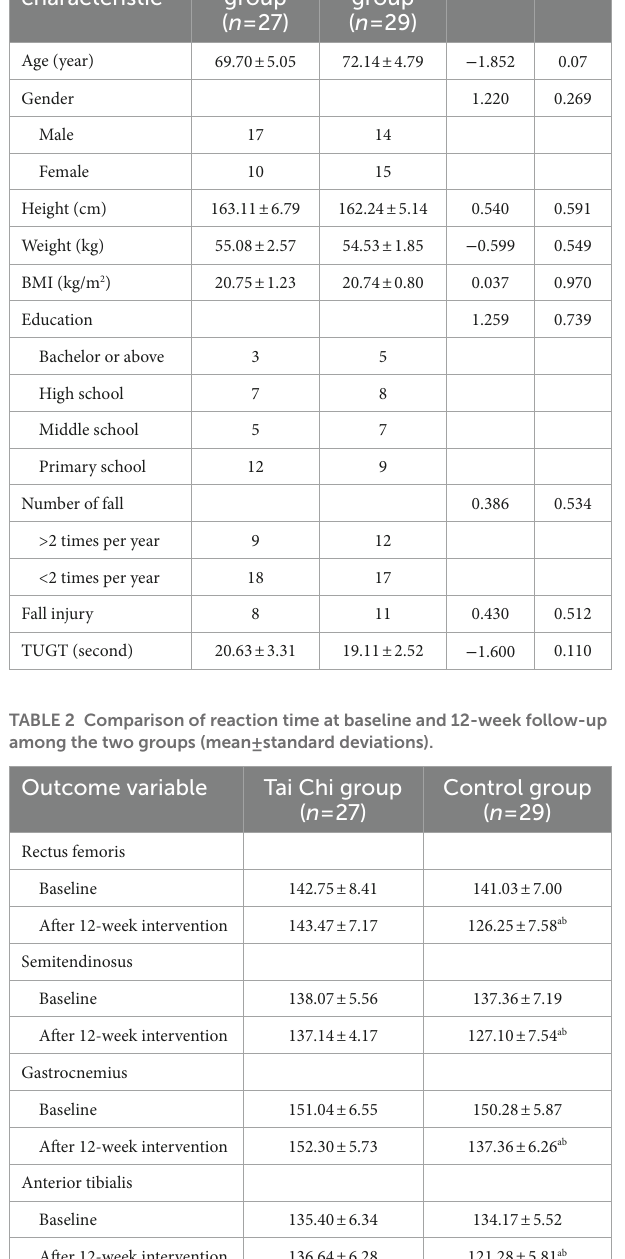
TABLE 1 Baseline demographic and clinical characteristic of the participants. Demographic characteristic